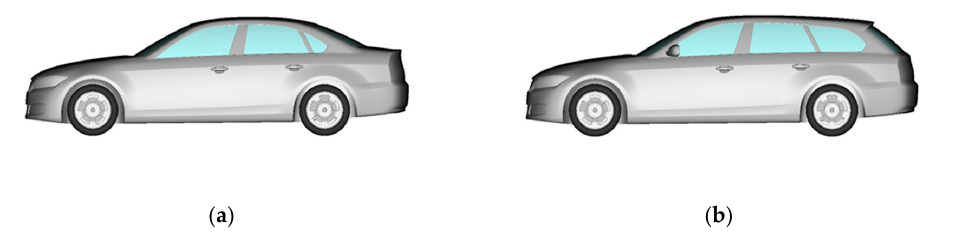
Figure 5. ( a ) DrivAer model, notchback; ( b ) DrivAer model, squareback.